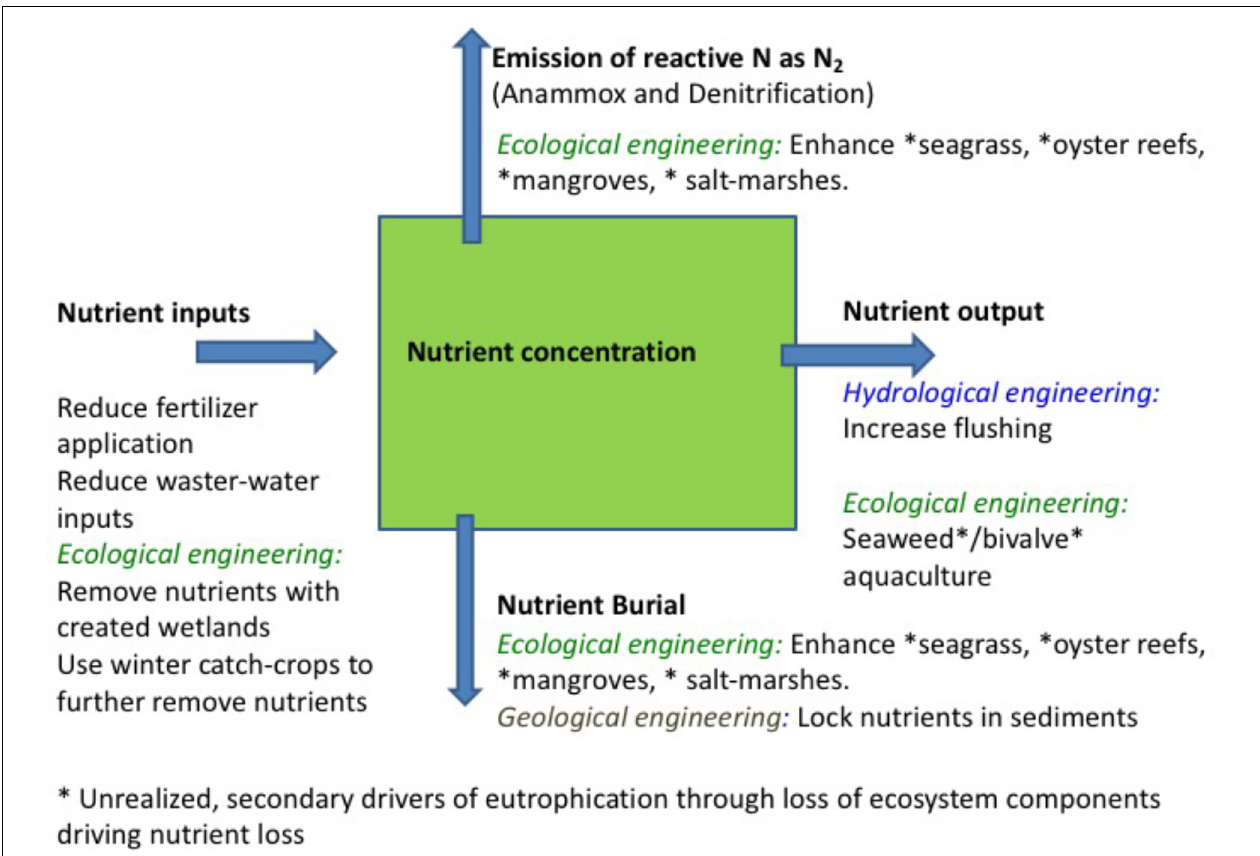
FIGURE 1 | Schematic representation of nutrient fluxes in coastal sediments, including, along with each main pathway, the main intervention options available.